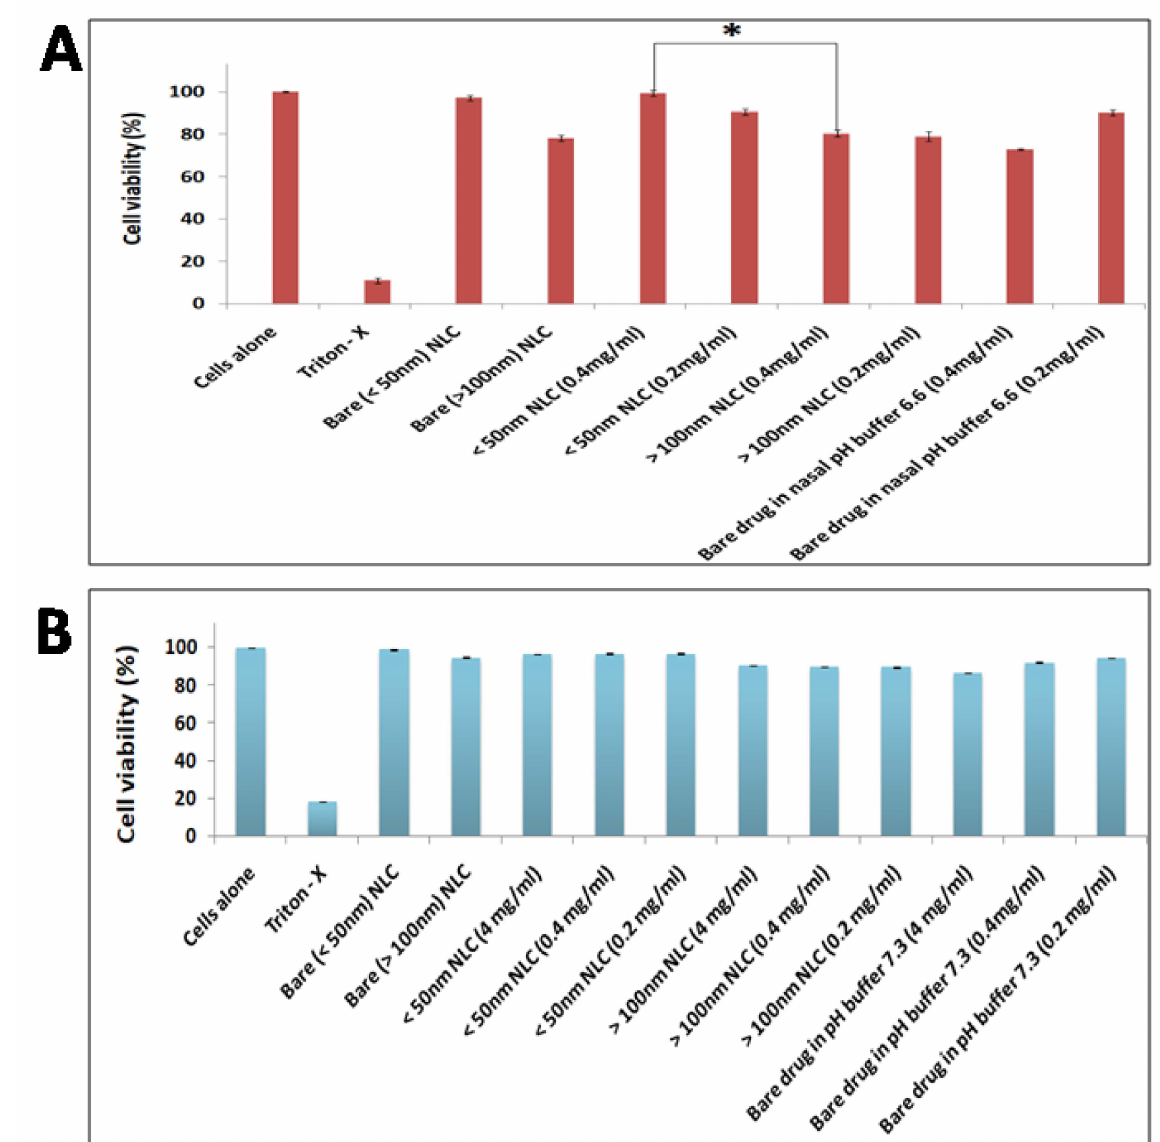
Figure 5. Cytocompatibility studies of the prepared Phenytoin sodium loaded nano lipid carriers and bare drug in ( A ) L929 and ( B ) HBCEC cell line. The level of statistical significance is expressed as a p -value; * indicates p <